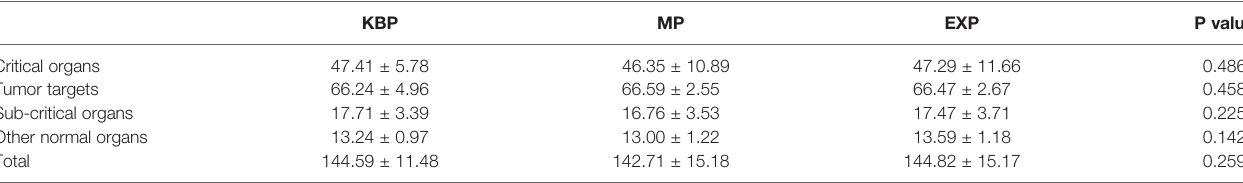
TABLE 5 | Plan quality metric scores of the three different plans for 17 nasopharyngeal carcinoma patients.